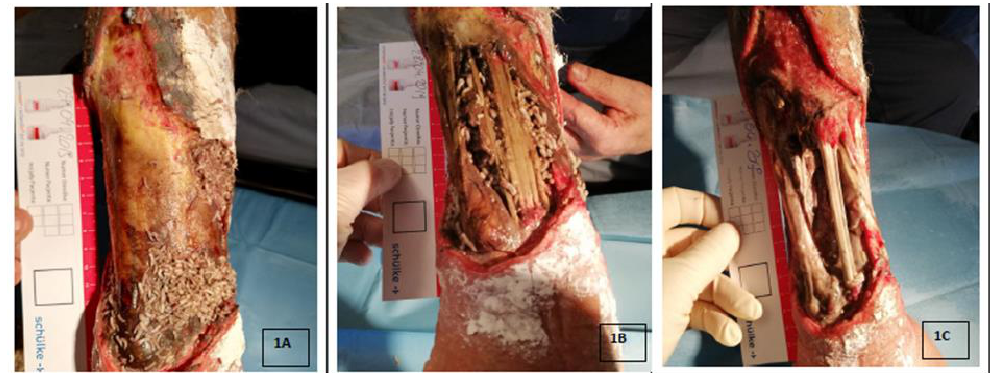
Figure 1. Process of debridement of a necrotic forearm wound with Lucilia sericata larvae; the wound has an area of nearly 200 cm², 100 free-range Lucilia sericata larvae from Biolab® culture were used. 1A. 24 hours since the larvae application, 1B. 48 hours since the larvae application, 1C. The condition after the removal of the larvae from the wound (over 72 hours). Note the exposed damaged ulna, and the extensor digitorum muscles. During therapy, pain sensations at the level of 2–3 Numeric Raring Scale (NRS).